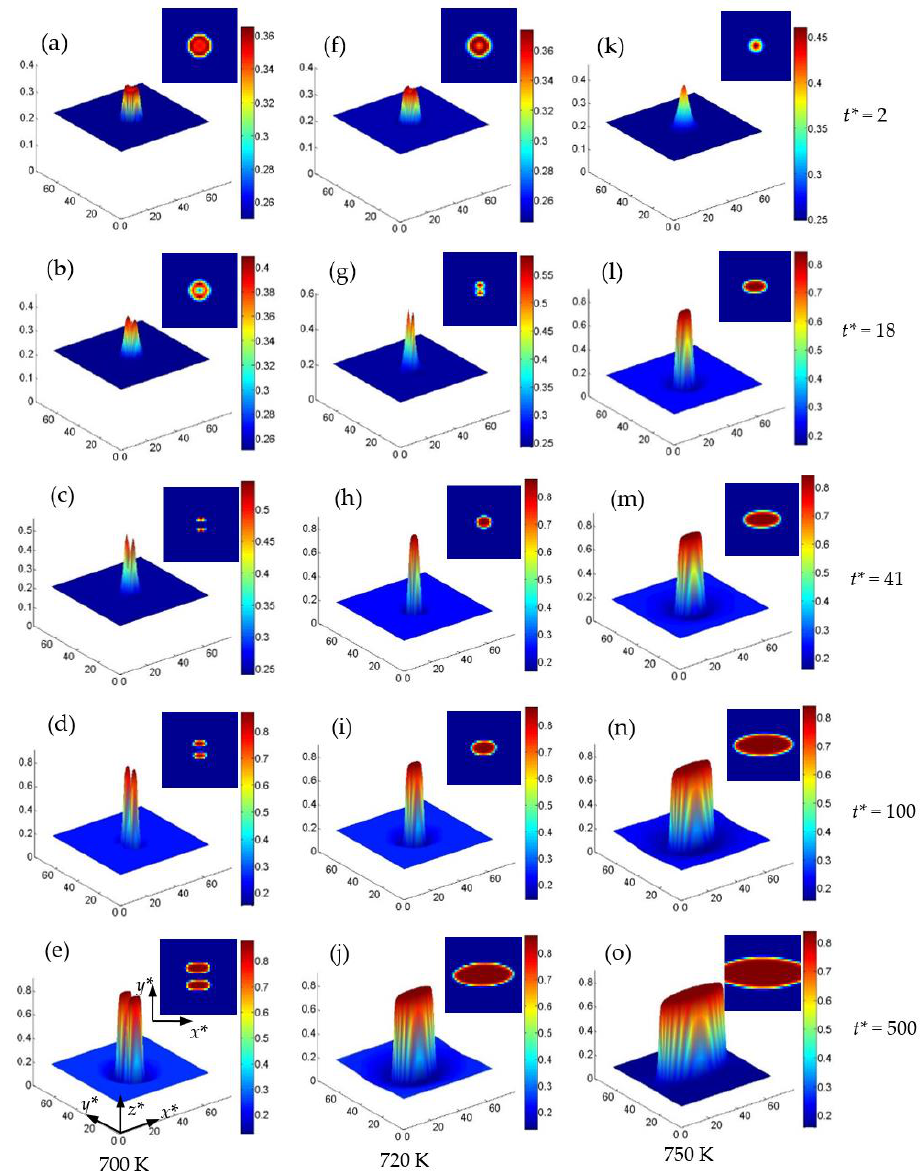
Figure 8. The concentration surface evolution of the Cr-enriched α′ phase from the initial circle regions with 35 at.% Cr and c i and ( k – o ) 750 K.